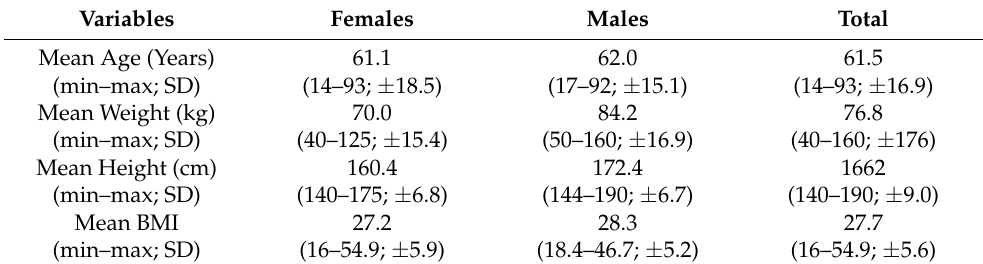
Table 1. Distribution by gender of personal data recorded.